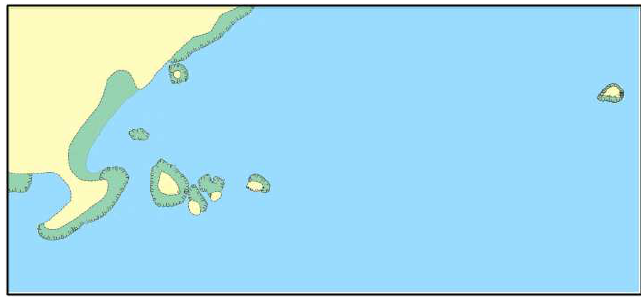
Figure 9. The marine environment in the electronic chart.